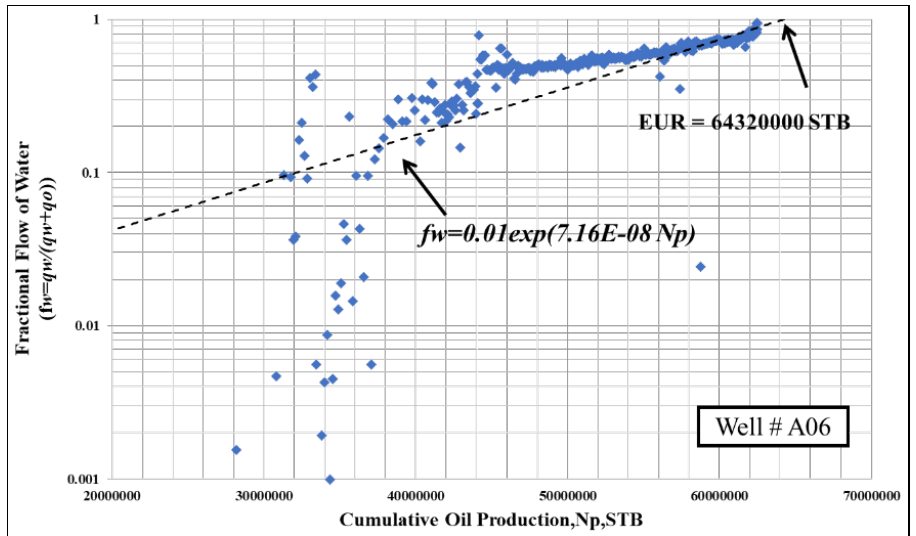
Figure 12. Fractional flow of water versus cumulative oil production for well A06